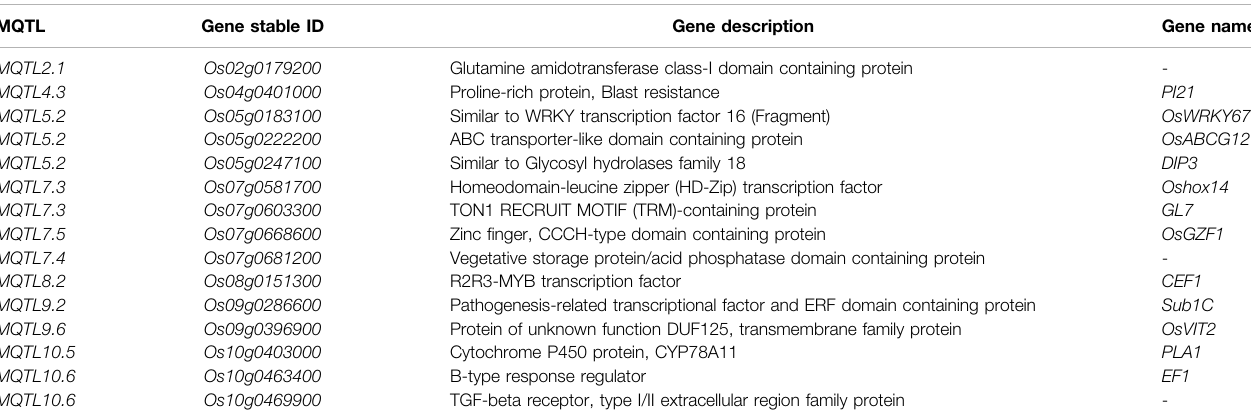
TABLE 4 | Selected 15 candidate genes showing response to nitrogen treatment. MQTL Gene stable ID Gene description Gene name